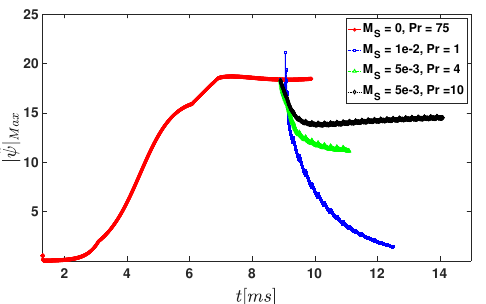
Figure 1. Time evolutions of the | ˜ ψ | Max for (2,1) mode for various levels of Prandtl number Pr , and the amplitude of the stochastic Zonal Flows (ZFs), M S .